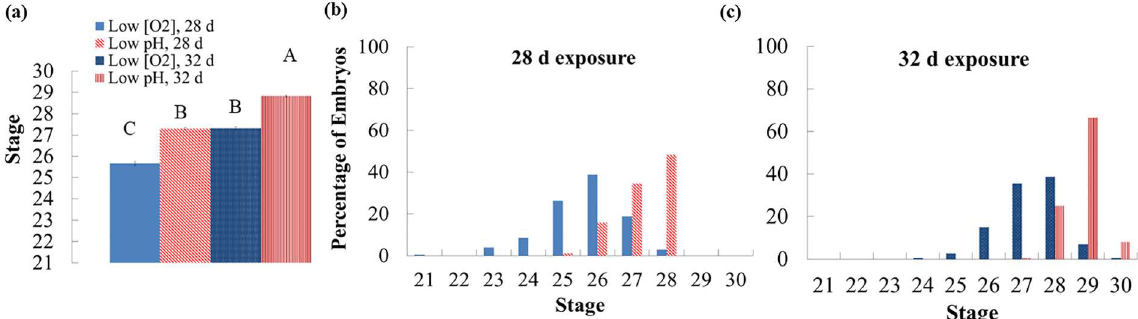
Fig 6. Experiment 2: Developmental categories of embryos across treatments and exposure duration. (a) Developmental categories of embryos removedfrom the experiment after 28 d of exposureto low [O 2 ] (light solid) or low pH (diagonalstripes) and after 32 d of exposure to low [O 2 ] (dark solid) or low pH (vertical stripes). Treatments were significantlydifferent (Kruskal-Wallis χ 2 = 472.8183, DF = 3, p < 0 . 0001 )and letters indicatesignificant difference amonggroups (Dunn pair-wisejoint ranking test, p < 0 . 0001 ). Bar = ± 1 standarderror. (b) Histogram of embryos removed after 28 d of exposureto low [O 2 ] (light solid) or low pH (diagonal stripes). (c) Histogram of embryos removed after 32 d of exposureto low [O 2 ] (dark solid) or low pH (vertical stripes).